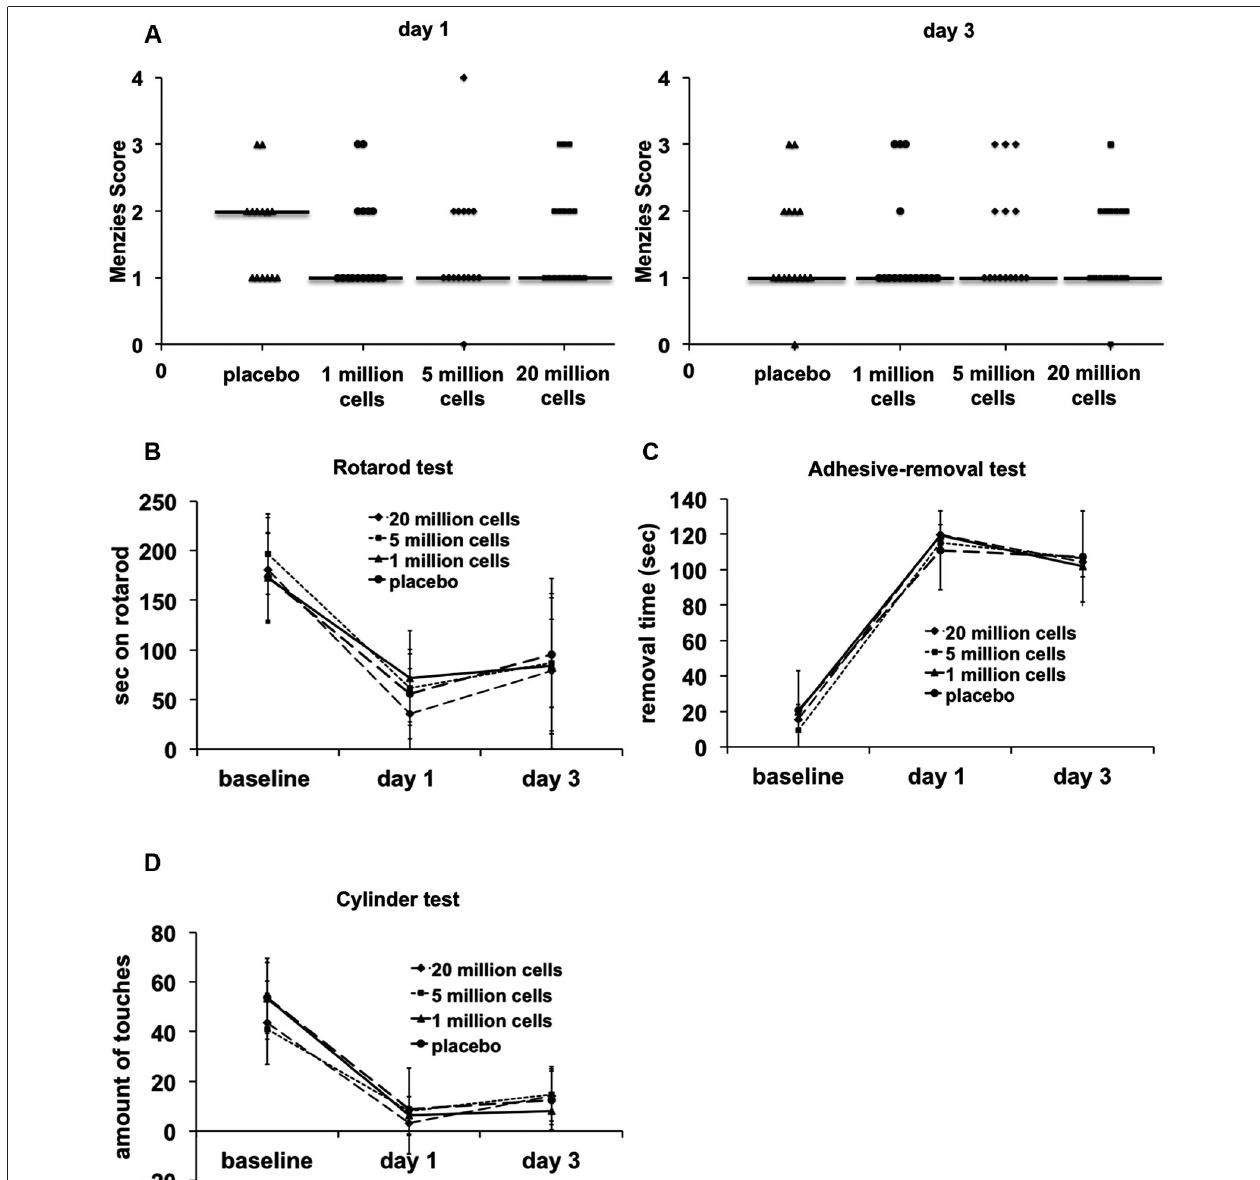
FIGURE 2 | Behavioral testing until day 3 after transient MCAO . No significant differences between the groups were detected in any of the functional tests ( n = 15–16/group). (A) Menzies score, P = 0.980. (B) Rotarod test, P = 0.670. (C) Adhesive-removal test, P = 0.922. (D) Cylinder test, P = 0.350.